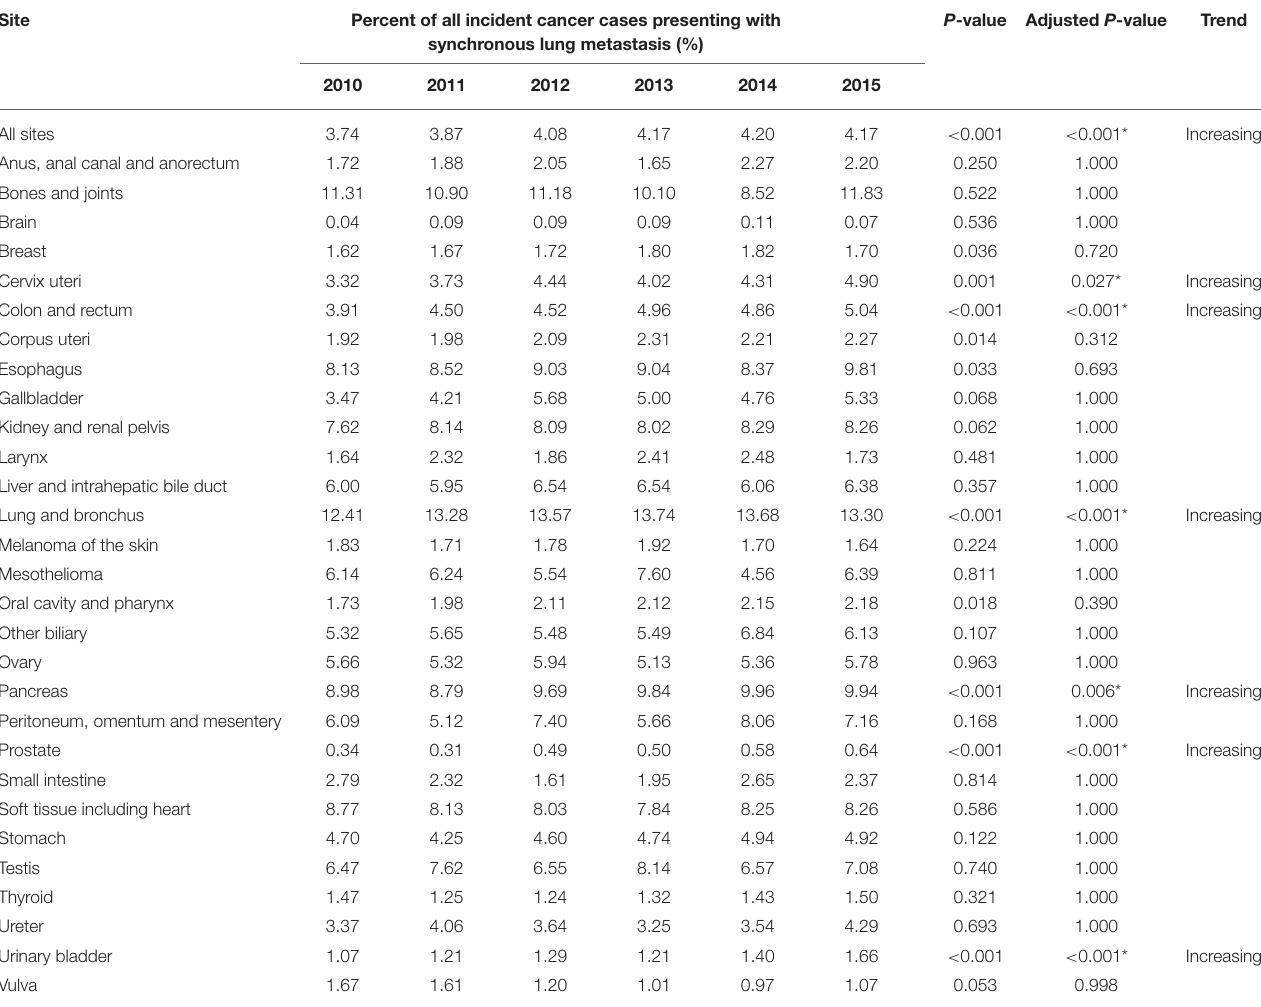
TABLE 2 | Time trend of the percent of all incidence cancer cases presenting with synchronous lung metastasis in the United States from 2010 to 2015, stratified by primary site of origin.